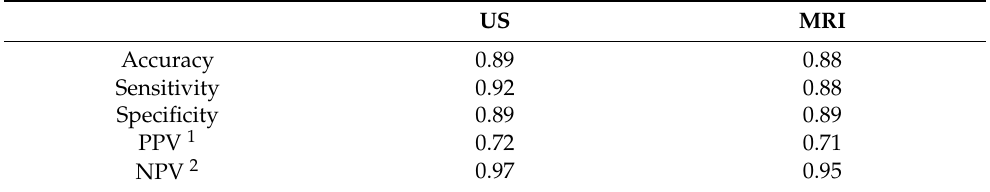
Table 4. Accuracy, sensitivity, specificity, and positive and negative predictive values for US and MRI.